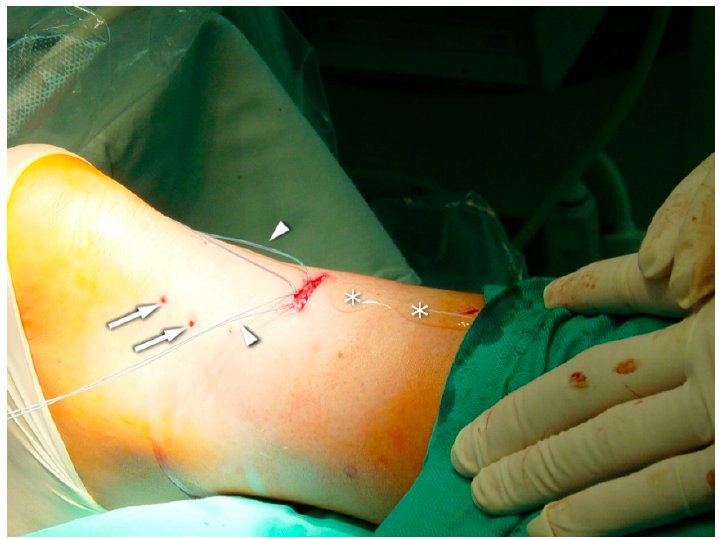
Figure 4. Distal sutures: the beginning of the third stage; note the punctures (arrows) resulting from distal suture deployment (arrowheads). Ultrasonic gel (asterix (*)) facilitates visualization during the placement of the proximal sutures.